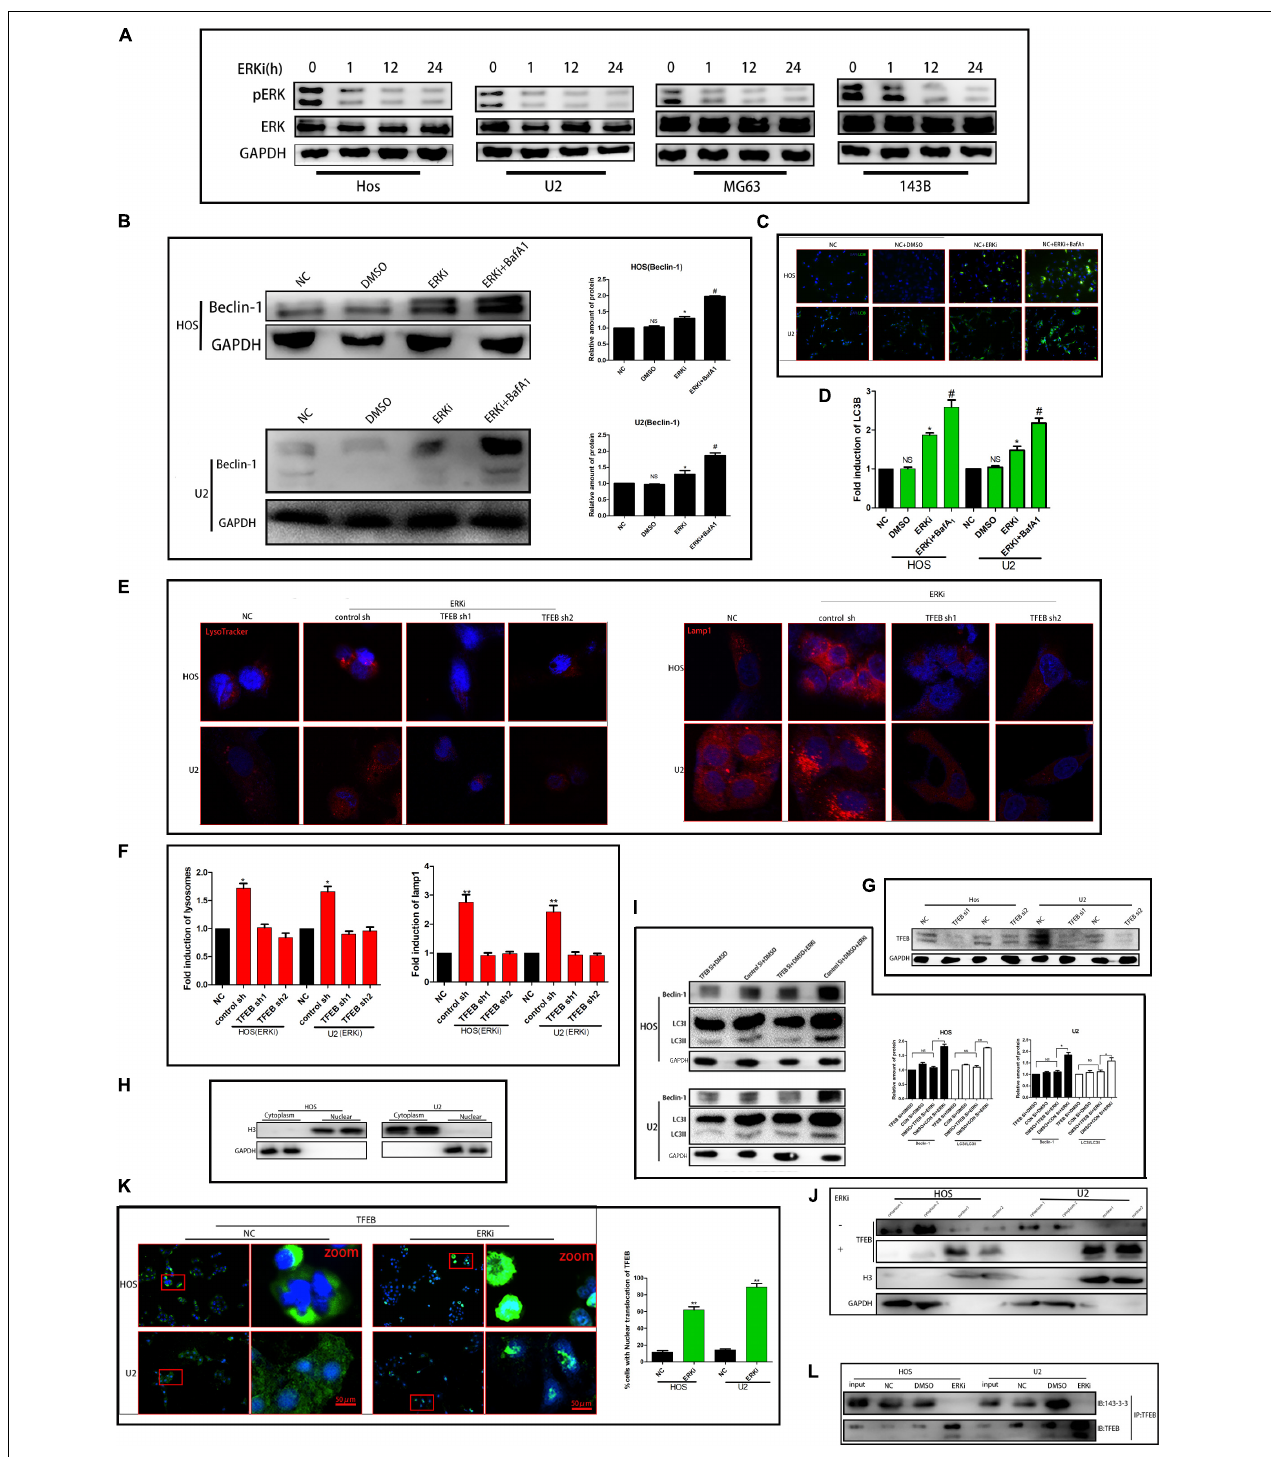
FIGURE 1 | ERKi treatment increases the autophagic flux through TFEB in OS cells. (A) Protein expression of p-ERK and ERK after ERKi treatment. (B) Protein expression and densitometric quantification of beclin-1 after ERKi and bafilomycin A1 treatment. GAPDH was used as a loading control and for band density normalization. (C,D) Immunofluorescence staining of LC3B (green) in OS cells 24 h after ERKi treatment. (E,F) Immunofluorescence staining of mitochondria. (G–I) Western blotting. (K) Immunofluorescence staining of TFEB. (J) Immunoblots for TFEB in the cytoplasmic/nuclear fractions of OS cells treated with ERKi. (L) ERKi disrupts TFEB interaction with 14–3–3. WCLs of OS cells immunoprecipitated (IP) with anti-TFEB, followed by immunoblotting (IB) with antibodies against 14–3–3 and TFEB ( n = 5 per group; ** p < 0.01 versus NC group; * p < 0.05 versus NC group).